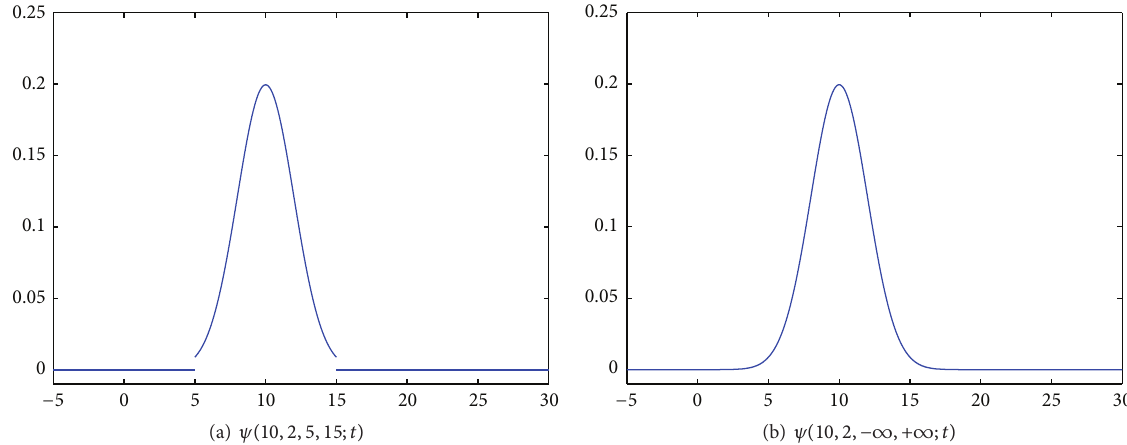
Figure 1: The example for the PDFs of truncated normal distribution and general normal